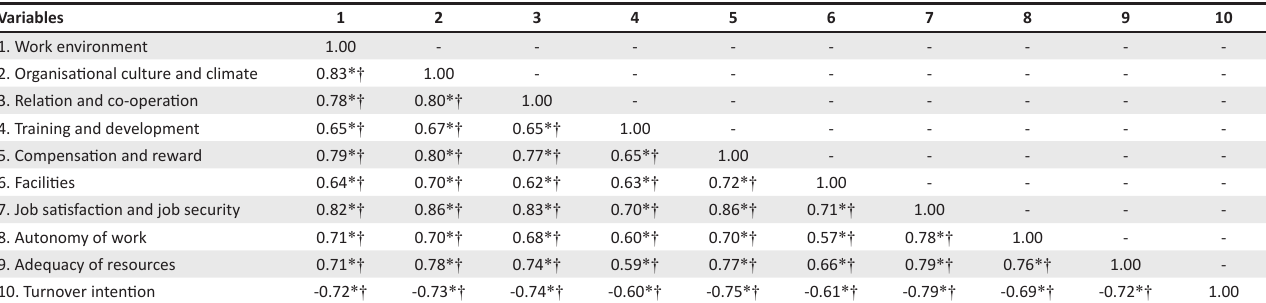
TABLE 2: Correlation matrix between variables. Variables